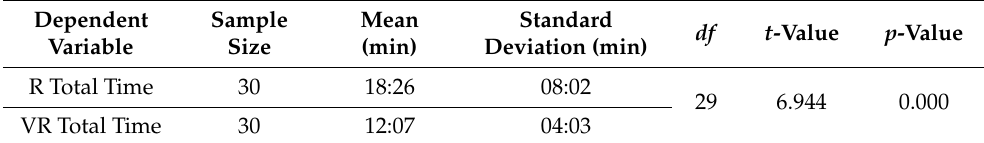
Table 4. Summary of hypothesis testing: Paired t